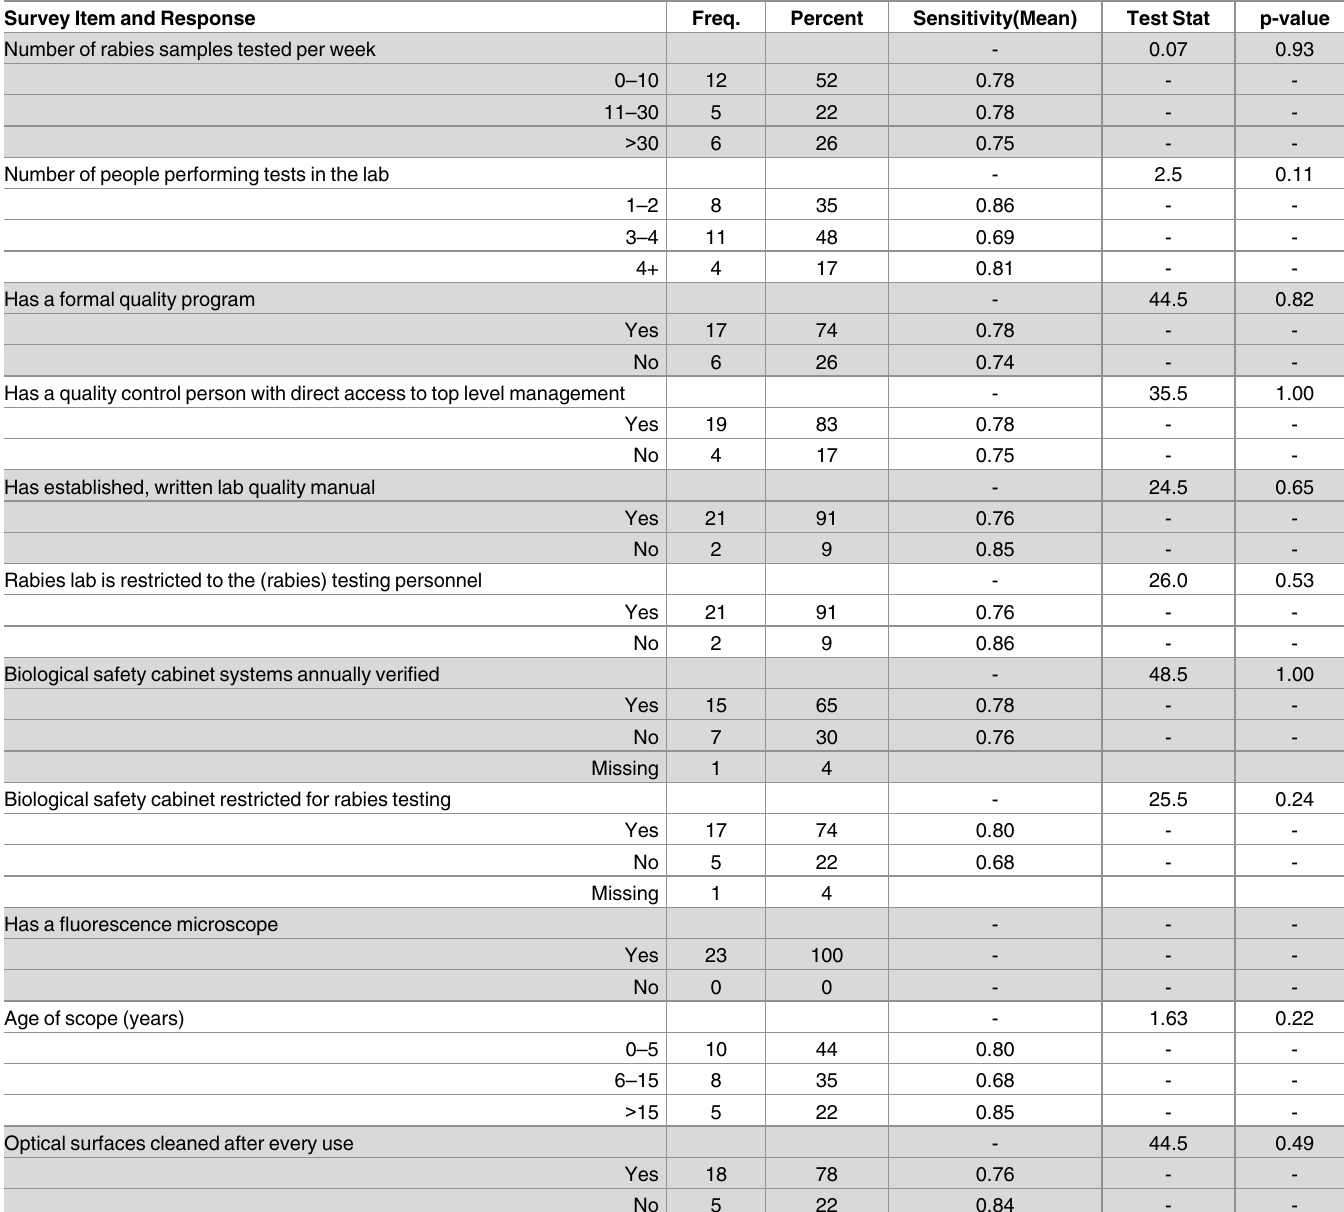
Table 4. Selected questions of the rabies laboratory practicesquestionnaire and results. Survey Item and